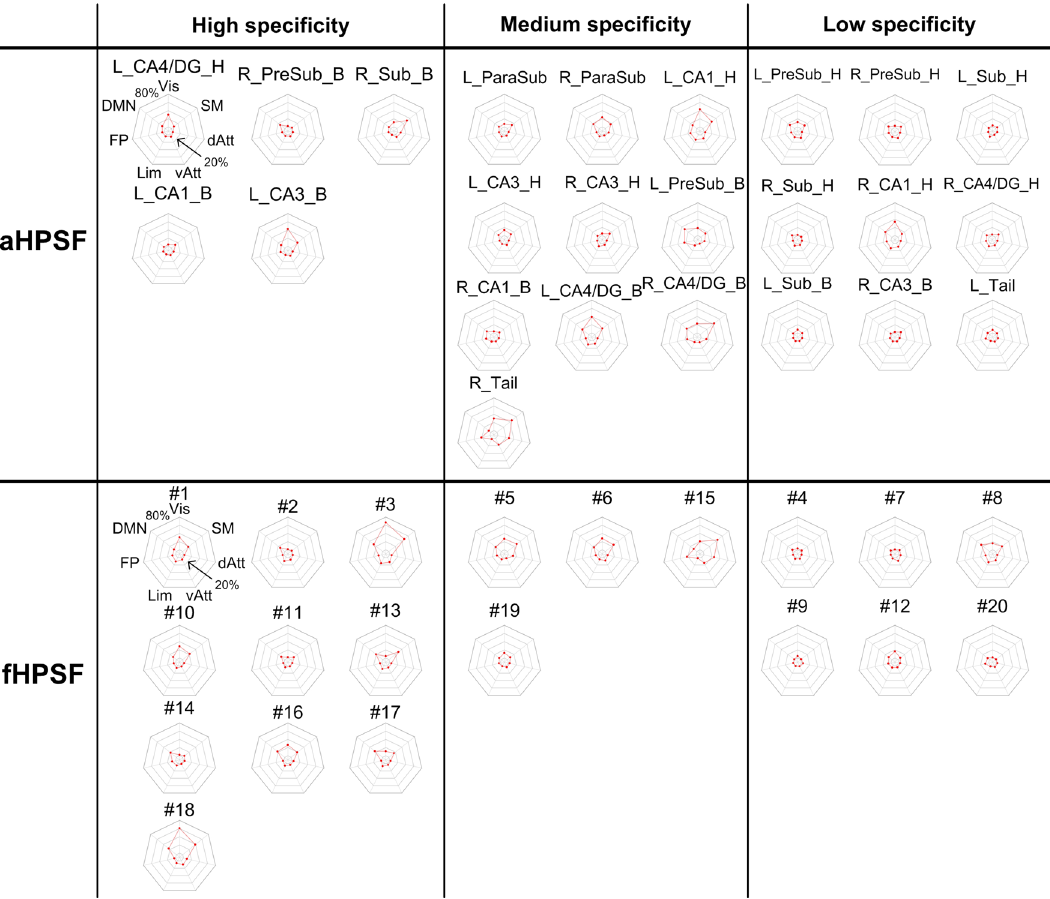
Figure 4. The percentages of iFC coverage of each RSN associated with aHPSFs and fHPSFs. The radar plots in the right-most columns of each panel shows the percentages of each iFC map with respect to the seven intrinsic functional networks. The innermost and outermost isoparametric curves in the radar plots represent 0% and 80% respectively. The increment between adjacent isoparametric curves is 20%. The charts of aHPSFs and fHPSFs are sorted together based on the hippocampal specificity and then classified into three groups. L left; R right; other abbreviations are as described in Fig. 3 and Table